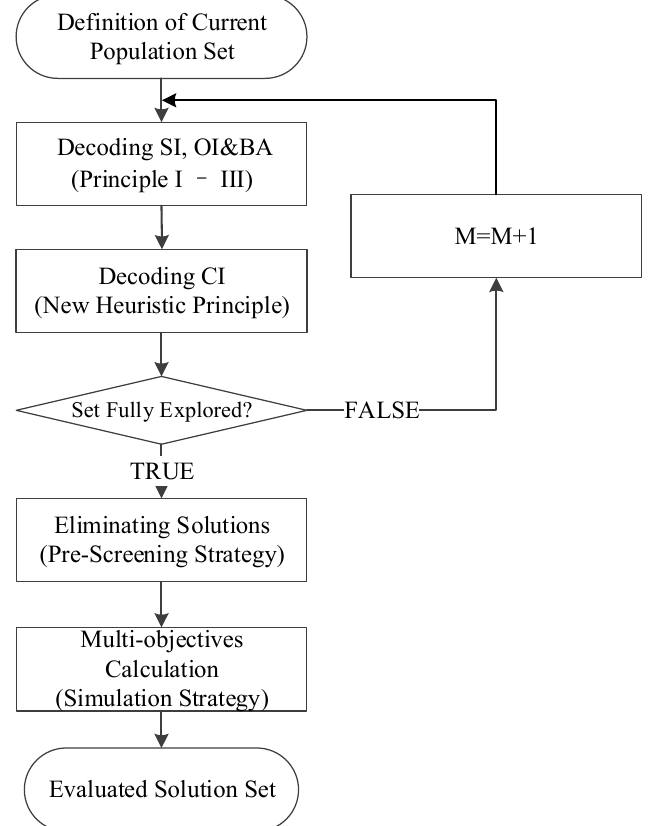
Figure 3. Logic diagram of the heuristic parts (the dashed frame in Figure 2).